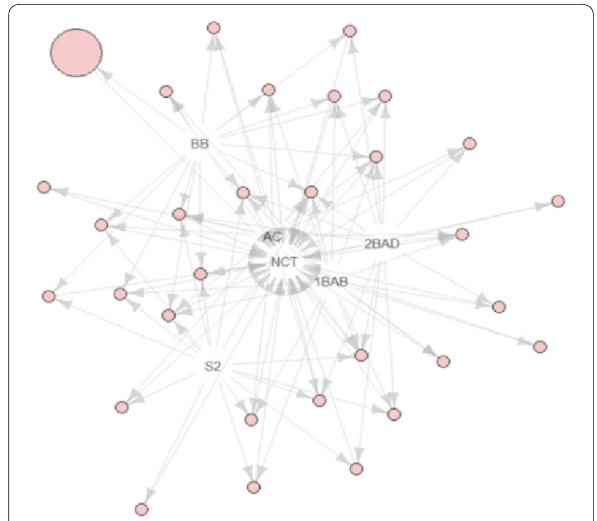
Figure 11 Schematic diagram of strong association rules with RHS item as